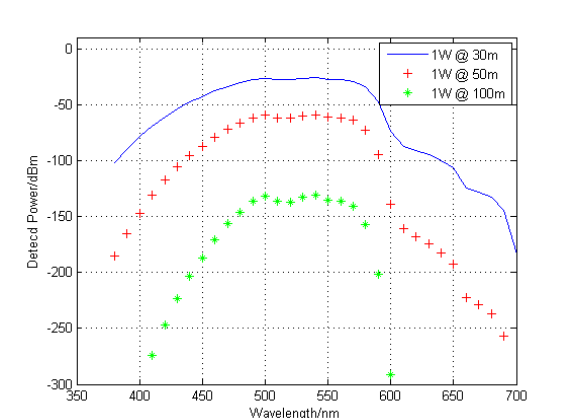
Figure 1. Detected power versus wavelength